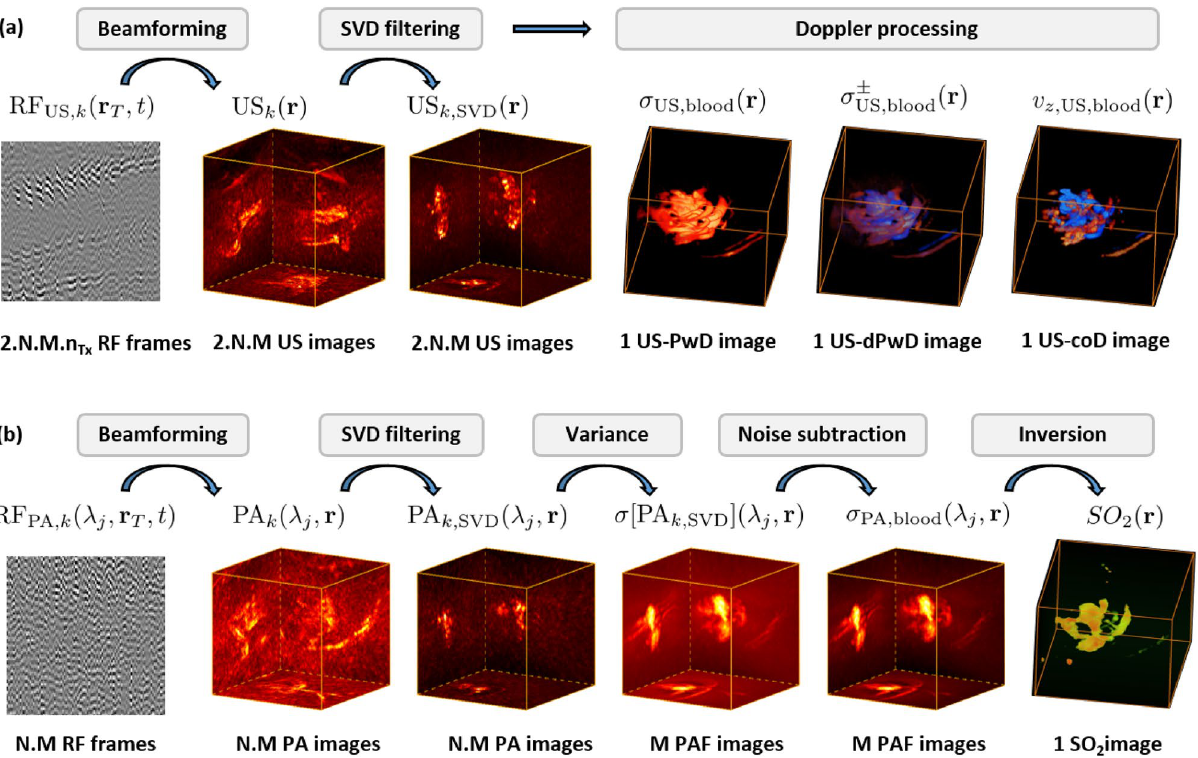
Figure 7. Data processing steps from radiofrequency signals (RF) to Doppler images ( a ) and photoacoustic fluctuation (PAF) images ( b ), applied to N individual sequences as defined in Fig. 1b. r T refers to the coordinates of each transducer element (RF frames) and r refers to the coordinates of the beamformed images.